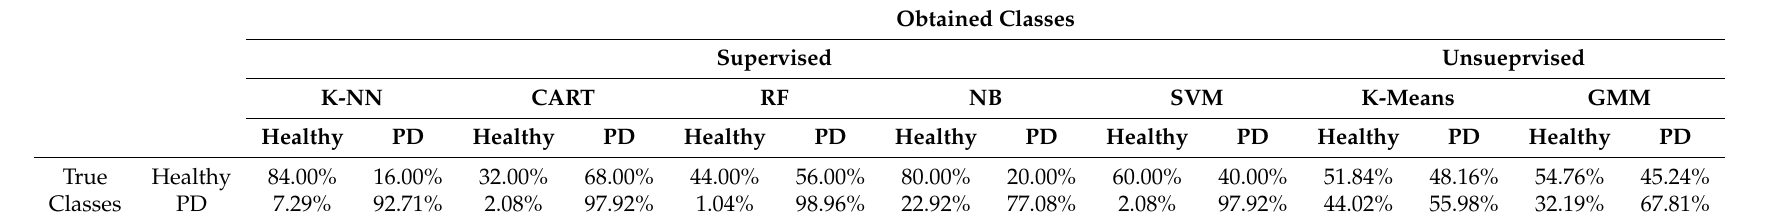
Table 9. Global confusion matrix obtained using the different classifiers in the case of the Hausdorff et al. sub-dataset.